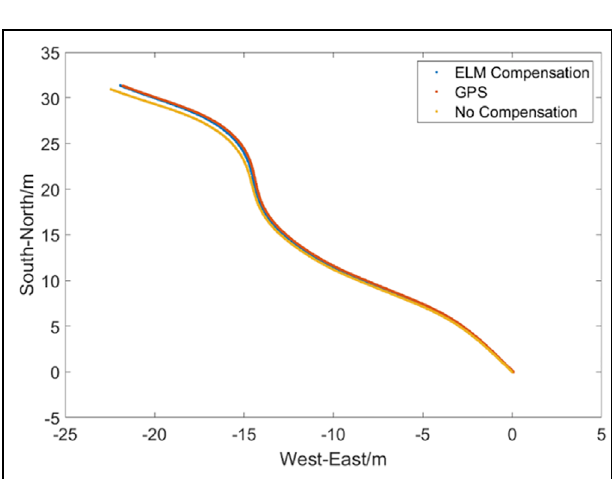
FIGURE 4 | Comparison result of the dead reckoning test under S-shaped condition.